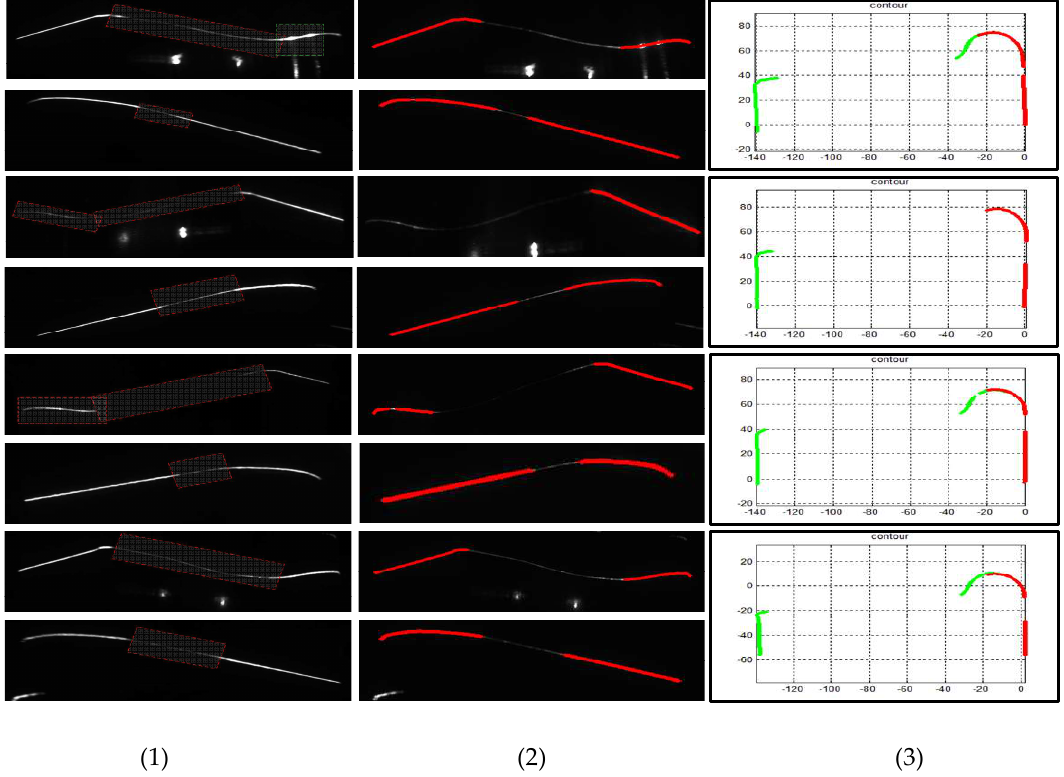
Figure 17. Wheel cross contour reconstruction without image processing. Column ( 1 ) presents the raw images. Column ( 2 ) shows the center extraction results of (1). Column ( 3 ) exhibits the wheel cross contour results of each wheel.